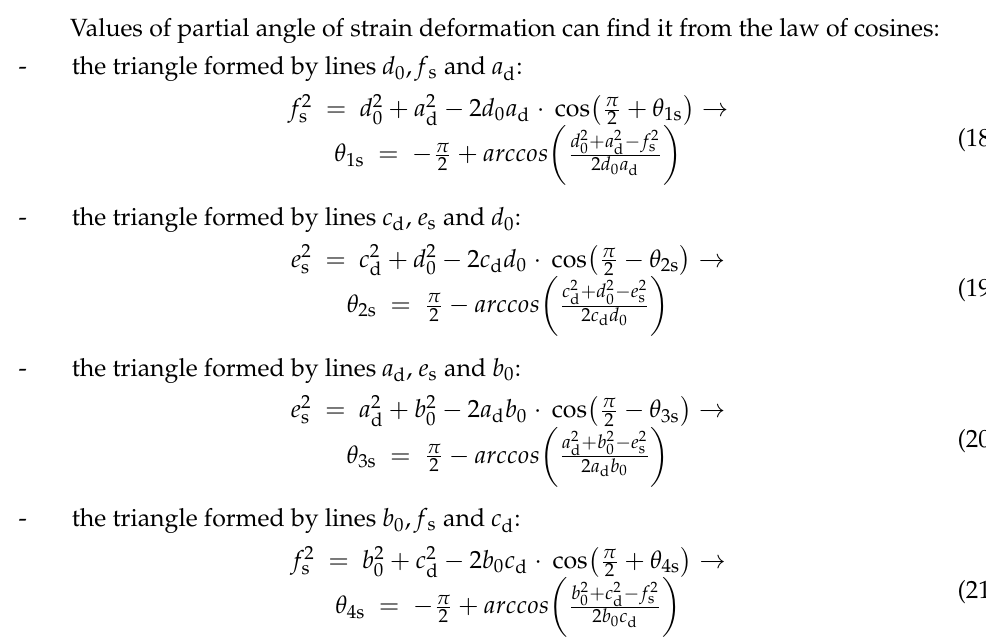
Figure 10. Deformation of measuring base resulting from shear deformation; H —horizontal shear force; 1 —rigid diaphragm; 2 —concrete foundation; 3 —masonry wall made of AAC; 4 —measuring base before deformation, 5 —measuring base after deformation; a d , c d —deformed horizontal part of the frame system; b 0 , d 0 —undeformed vertical part of the frame system; e s , f s —deformed diagonal part of the frame system (result from shear deformation); θ 1 s , θ 2 s , θ 3 s , θ 4 s —values of partial strain deformation angles.